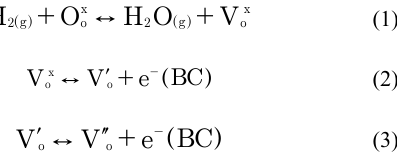
Figure 5. Resistance versus time plot for the ZnO NRs and ZnO NRs-Au NPs samples supported on Al at 300 (b) O 2